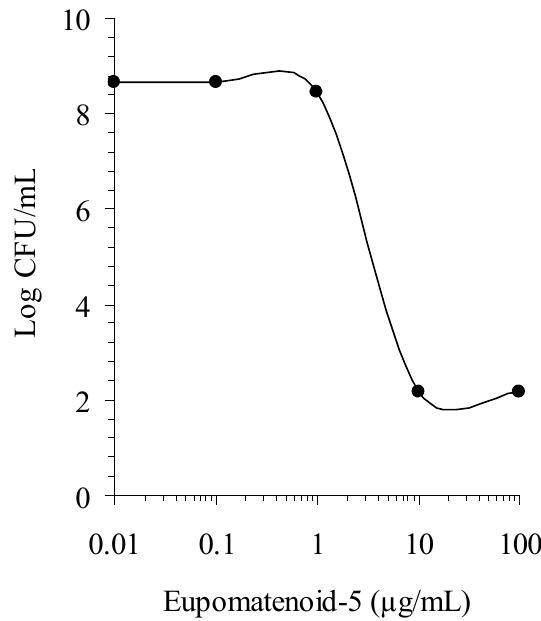
Figure 2. Dose-response effect of eupomatenoid-5 against Staphylococcus aureus . The microorganism suspension containing 10 6 CFU/mL was added to sterile tubes containing compound to obtain the indicated final concentrations. CFU were determined for each tube after 24-h incubation at 37